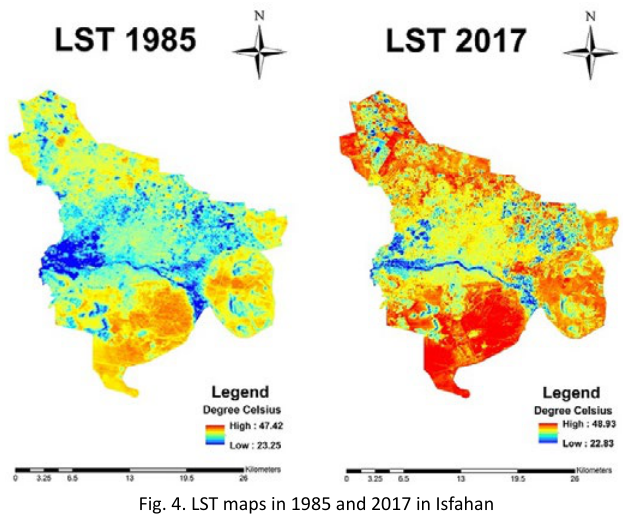
Fig. 4: LST maps in 1985 and 2017 in Isfahan Fig. 4. LST maps in 1985 and 2017 in Isfahan